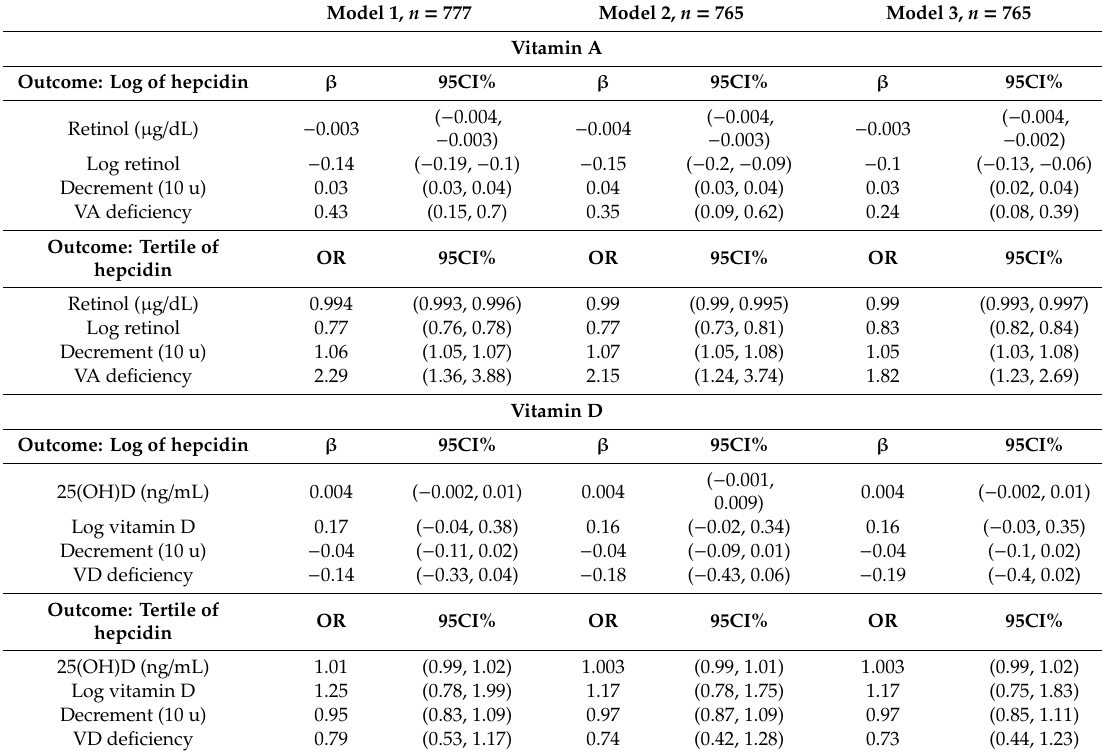
Table 3. Adjusted linear and ordinal regression model for Vitamin A and D status and its association with log-hepcidin levels in